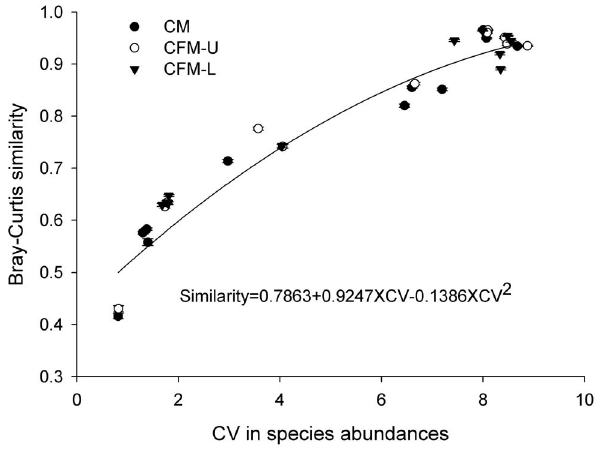
Figure 3. The relationship between the coefficient of variation in species abundances and the Bray-Curtis similarity index for communities with (CFM-U, and CFM-L) and without (CM) facilitation. The parameter values are the same as in Fig. 1. Each data point represents the mean 6 SE.